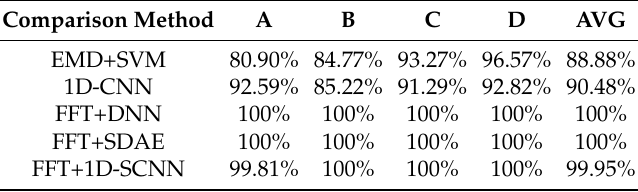
Figure 9. Fault diagnosis accuracy of 1D-SCNN. Table 5. Comparison of experimental results of different